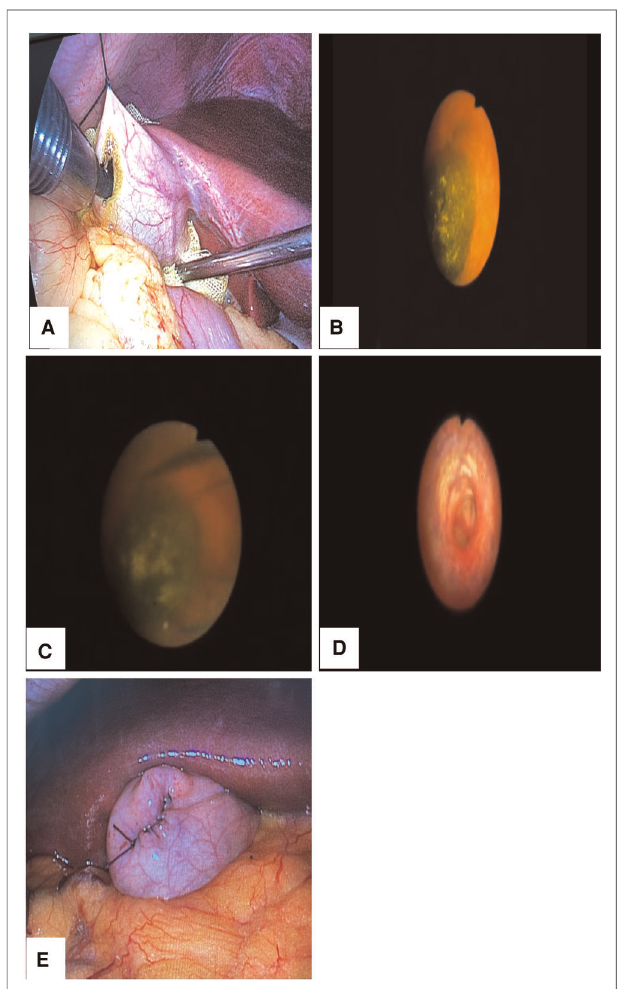
FIGURE 2 | Intraoperative illustration. ( A ) The bottom of the gallbladder was suspended from the abdominal wall, and the choledochoscope was inserted into the gallbladder through a 12-mm disposable trocar. ( B ) Exploration found incarcerated gallbladder neck stones. ( C ) A stone extraction basket was used to remove the stone. ( D ) Exploration was undertaken to at least two spiral valves of the cystic duct after stone extraction to ensure that no stones remained and that the bile re fl ux was good. ( E ) The gallbladder incision was sutured with 4/0 absorbable